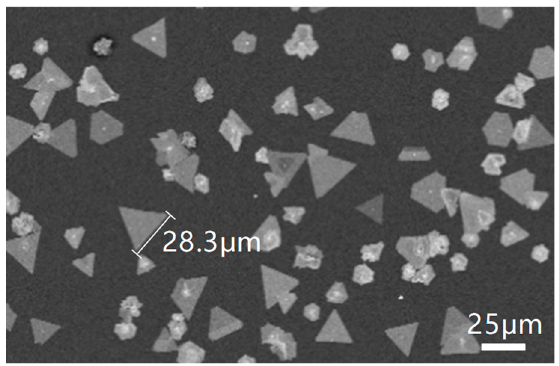
Figure 2. Scanning electron microscopy (SEM) image of WS 2 grown on SiO 2 /Si substrate.